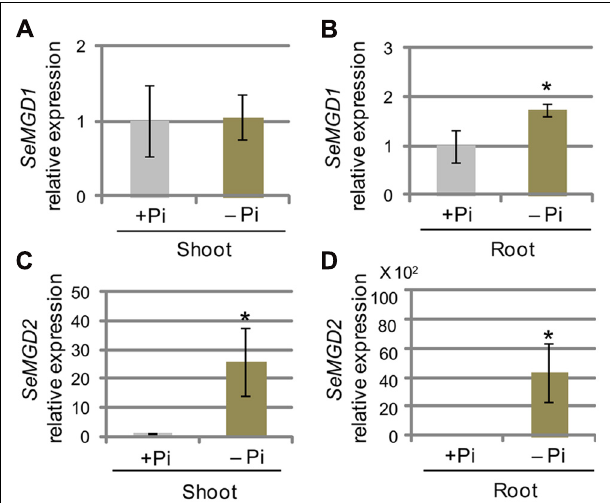
FIGURE 4 | Quantitative RT-PCR analysis of SeMGD expression. (A–D) Relative abundances of SeMGD1 (A,B) and SeMGD2 (C,D) mRNAs in shoots (A,C) and roots (B,D) of plants grown under phosphate (Pi)-sufficient ( + Pi) and Pi-depleted ( − Pi) conditions for 14 days after 5 days of growth on Pi-sufficient medium.Values represent the mean ± SD from three independent measurements. * P < 0.05.